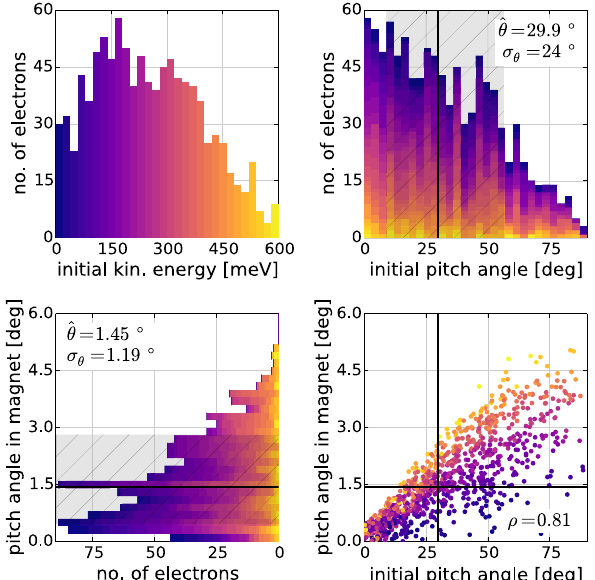
Fig. 13 Simulated angular distributions of 1000 electrons at U start = − 18 , 598 . 7V. The plot uses the same approach as Fig. 12, but shows the correlation between the initial pitch angle, θ 0 , and the produced pitch angle in the spectrometer entrance magnet, θ . Here the distributions are colored by the initial energy, which is normal-distributed as shown in the upper left panel